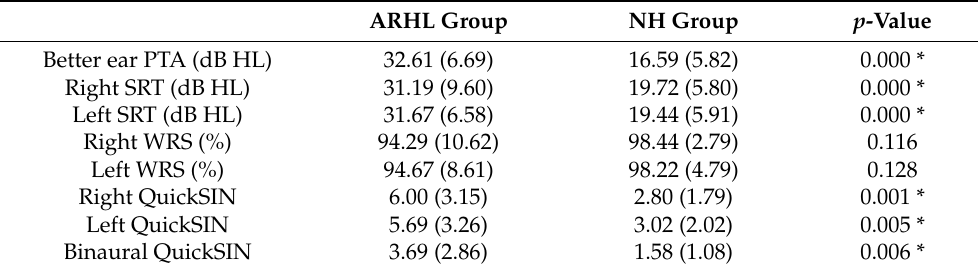
Table 2. Group Means for Audiological